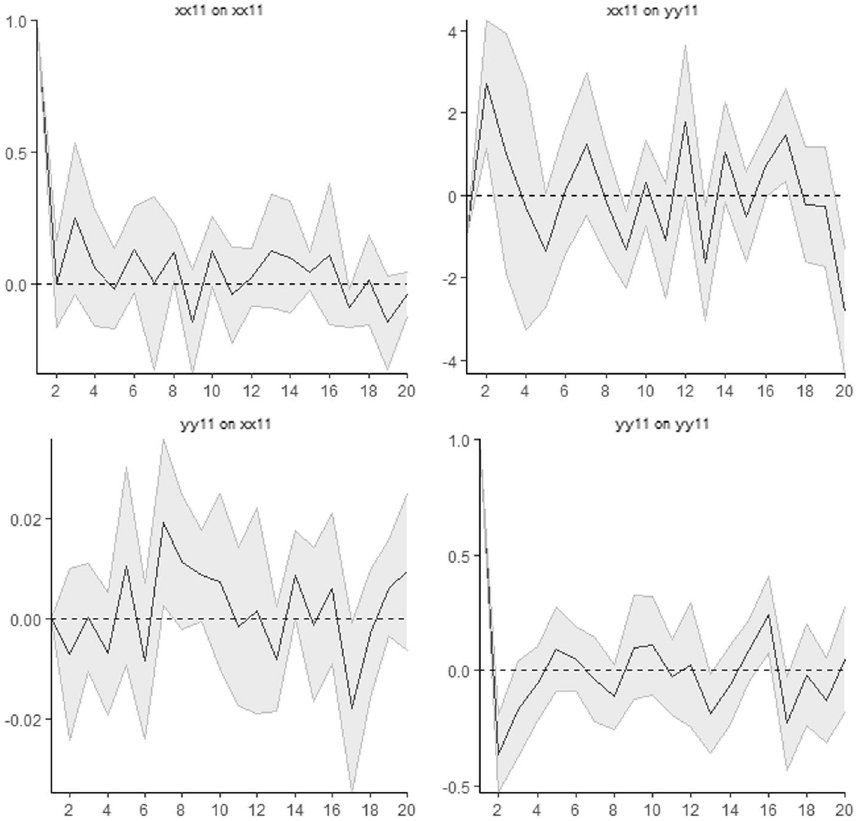
Fig. 8 The subperiod analysis of linear IRF for the period in which CPI > IR (Negative interest rates)